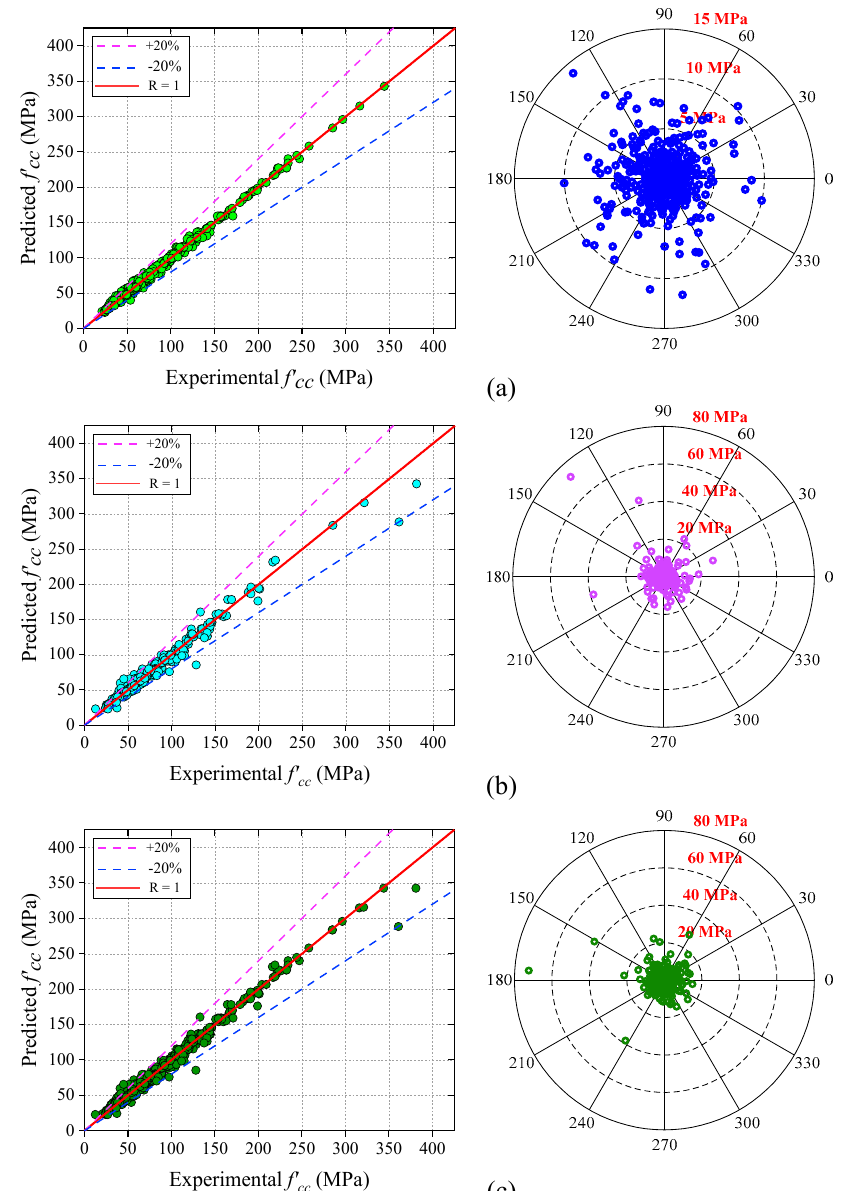
Figure 8. Sca tt er and absolute error plot of ANN model; ( a ) training, ( b ) validation, ( c ) testing, and ( d ) whole datasets.